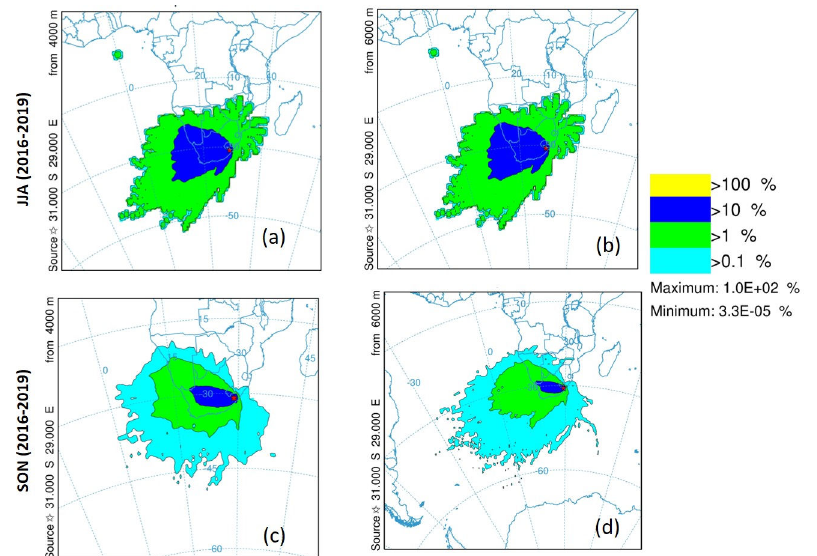
Figure 11. Seasonal trajectory frequency plots from a starting location of 31.000 ◦ S, 29.000 ◦ E during the period of 2016–2019 at ( a ) 4000 m and ( b ) 6000 m above ground level for the JJA season, and ( c ) 4000 m and ( d ) 6000 m above ground level during the SON